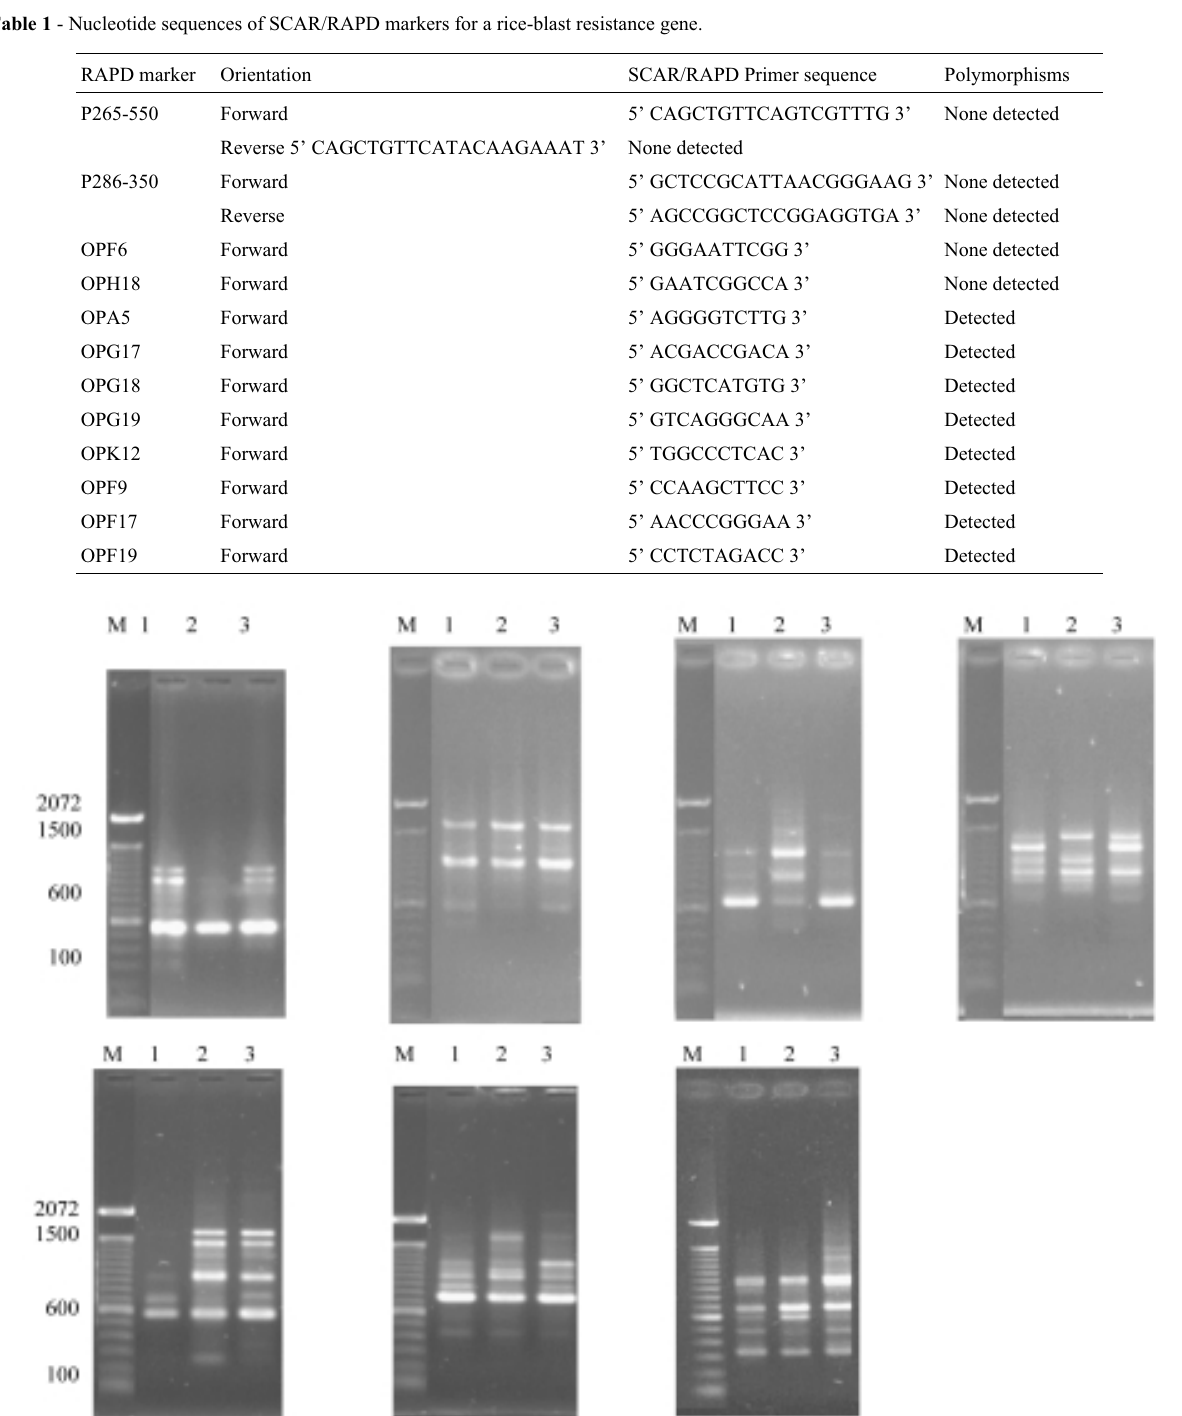
Figure1 -EthidiumBromidestainedelectrophoreticprofileofRAPDmarkers(A=OPA5 1000 andOPA5 1200 ,B=OPF9 600 ,C=OPF19 600 ,D=OPF17 1200 , E = OPG17 700 , F = OPG18 850 , G = OPG19 500 and OPG19 600 ) for resistant line 11 (sample 1), susceptible line 165 (sample 2) and resistant line “labelle”(sample 3). M = 100 base-pair marker.